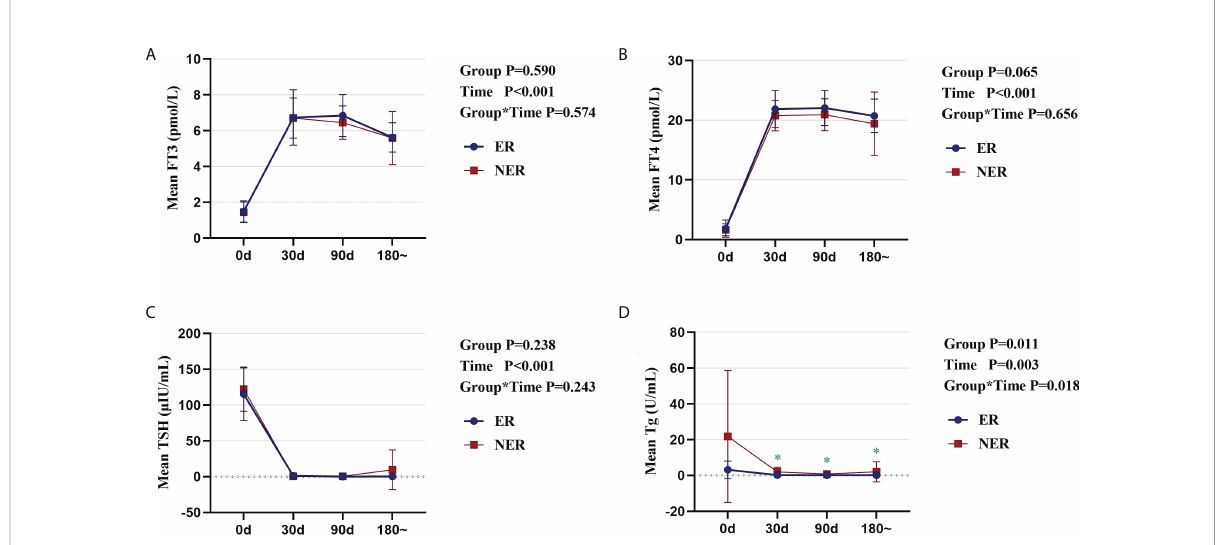
FIGURE 1 Comparative analysis of the dynamic changes and differences in thyroid function and Tg in ER and NER groups before and after RAIT. Changes in serum FT3 (A) , FT4 (B) , TSH (C) , and Tg (D) in the two groups of patients before and after RAIT. ER, excellent response; NER, non-excellent response; RAIT, radioactive iodine treatment; Tg, serum thyroglobulin; d, day; 180~, expressed as 6 months to 1 year after